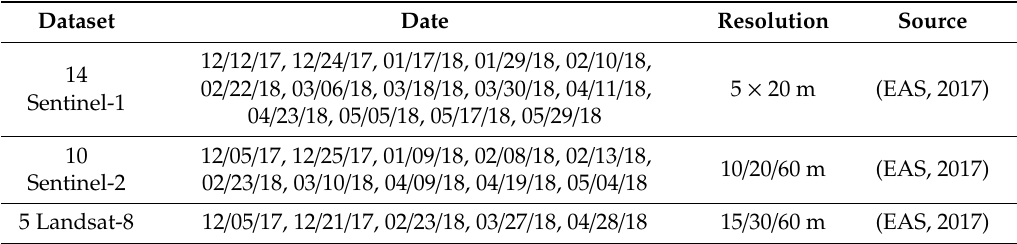
Table 2. Description of the parameters of Sentinel-1 products.